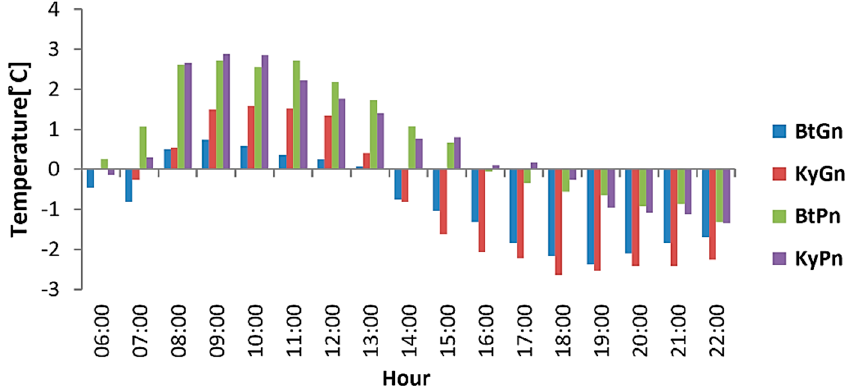
Figure 8. The difference of air temperatures in the wet season.